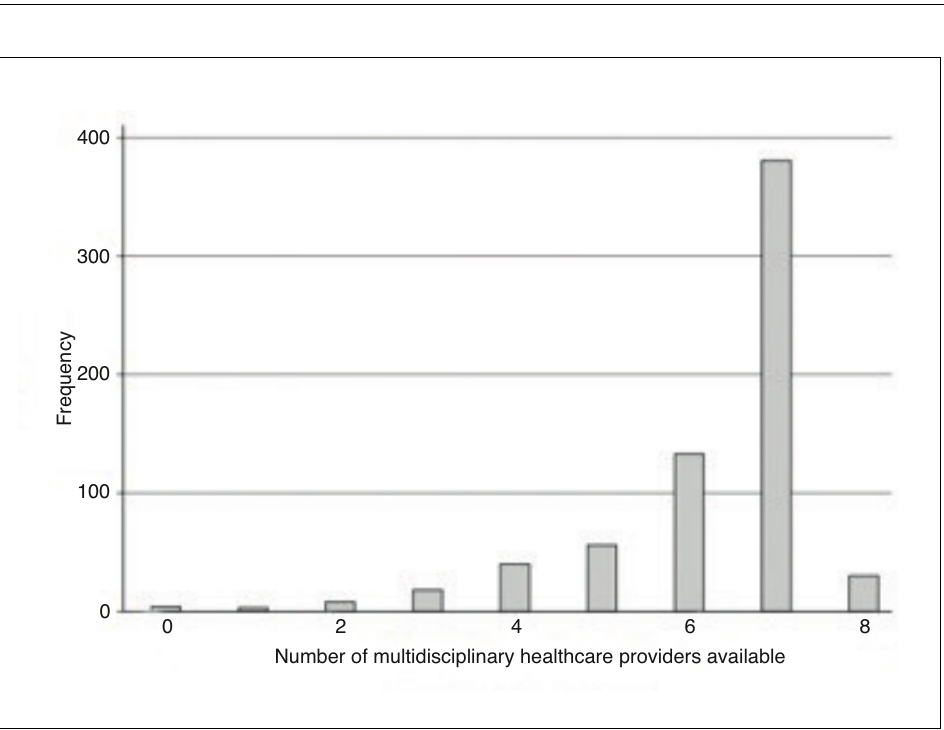
White R A et al . BJGP Open 2018; DOI: 10.3399/bjgpopen18X101609 6 of